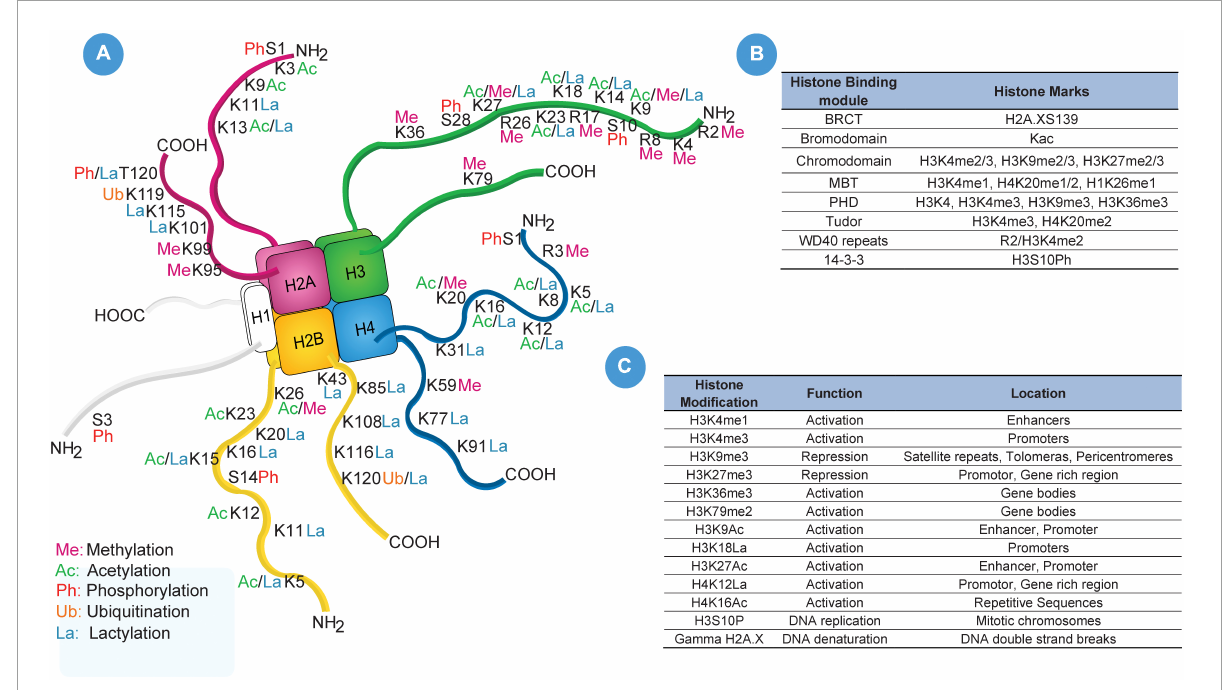
FIGURE3 Histone Modifications. (A) Illustrates pictorial representation of all known till date post-translational modification of histone amino-terminal tail and their location regions. (B) Portraits frequency used histone marks and their histone binding modules such as BRCT, bromodomain, chromodomain, MBT, PHD, Tudor, WD40 repeats and 14-3-3. (C) List of frequently used histone-modified regions, functions, and locations in DNA sequence which includes H3K4me1, H3K4me3, H3K9me3, H3K27me3, H3K36me3, H3K79me2, H3K9Ac, H3K9La, H3K27Ac, H4K12La, H4K16Ac, H3S10P, and Gamma